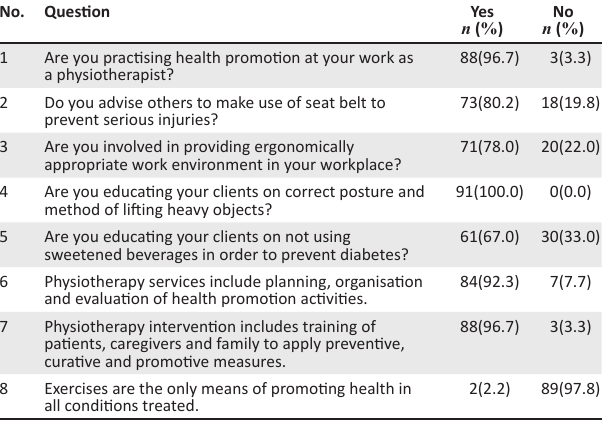
FIGURE 3: Pie chart showing institutions where physiotherapists are currently working. TABLE 1: Physiotherapy practice on health promotion.